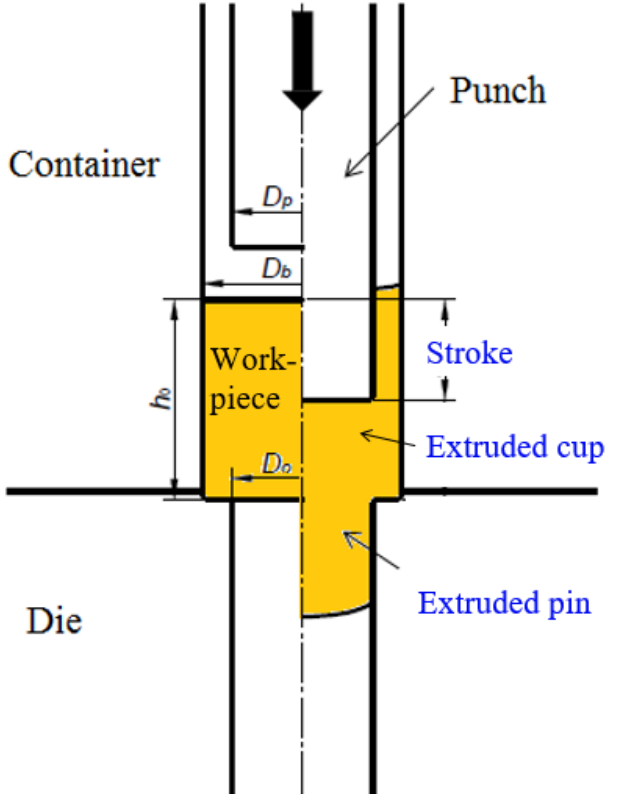
Figure 3. Configuration of CFBE process, left: before extrusion; right: after extrusion.